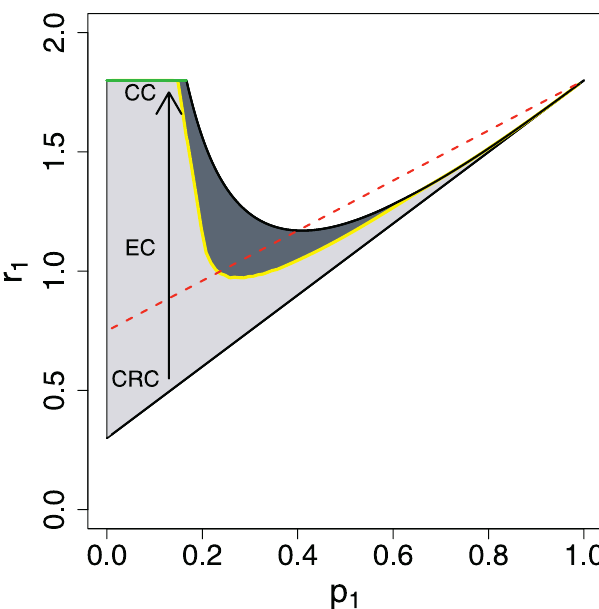
Figure 3. Bifurcation Diagram Showing the Parameter Regions where Evolutionary and Cryptic Cycles Result from Rapid Prey Evolution in Model